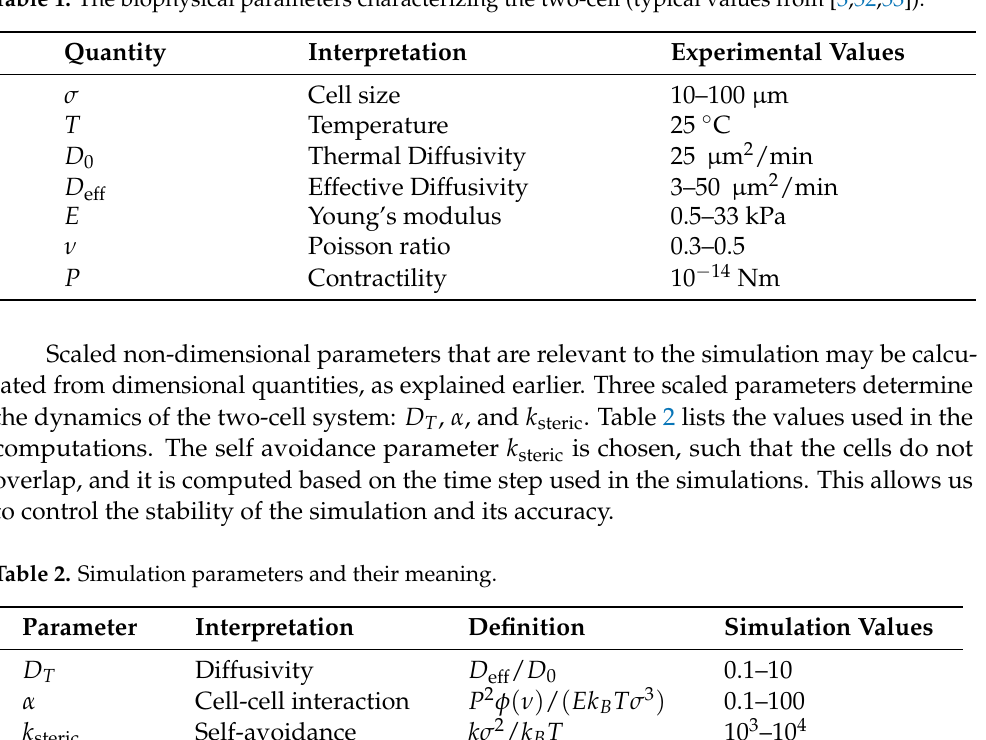
Table 1. The biophysical parameters characterizing the two-cell (typical values from [3,52,53]).